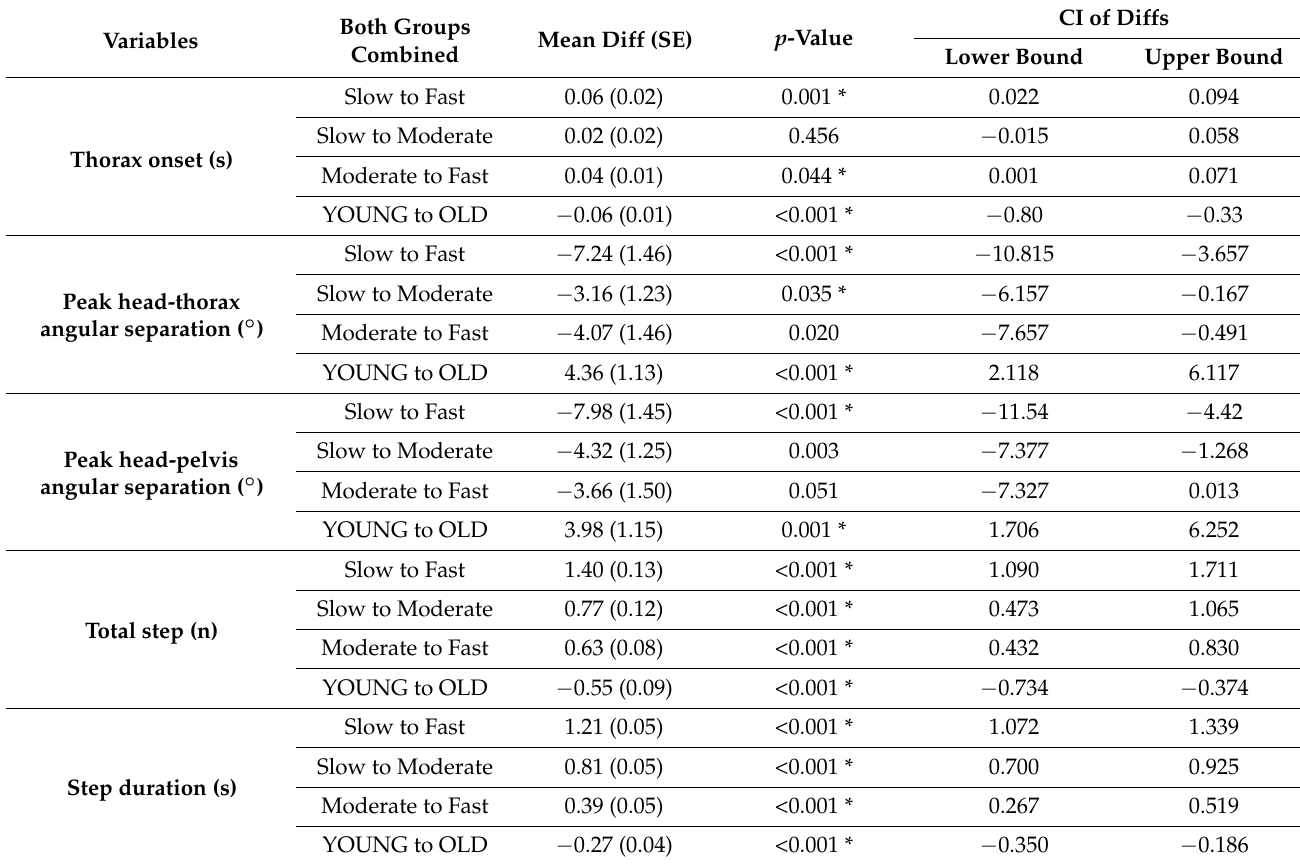
Table 4. Post hoc comparisons for the main effects seen in the MM ANOVA, where no interactions between group and turning speed were